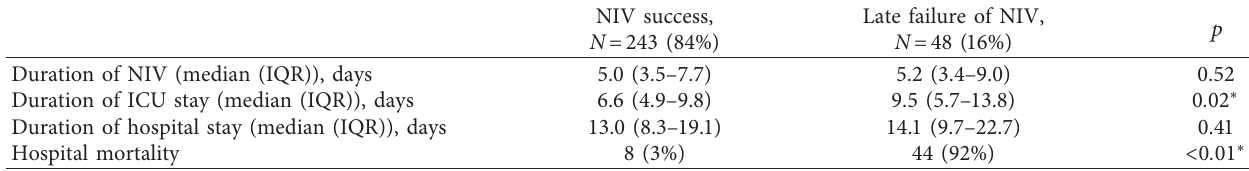
Table 3: Outcomes between patients with NIV success and late